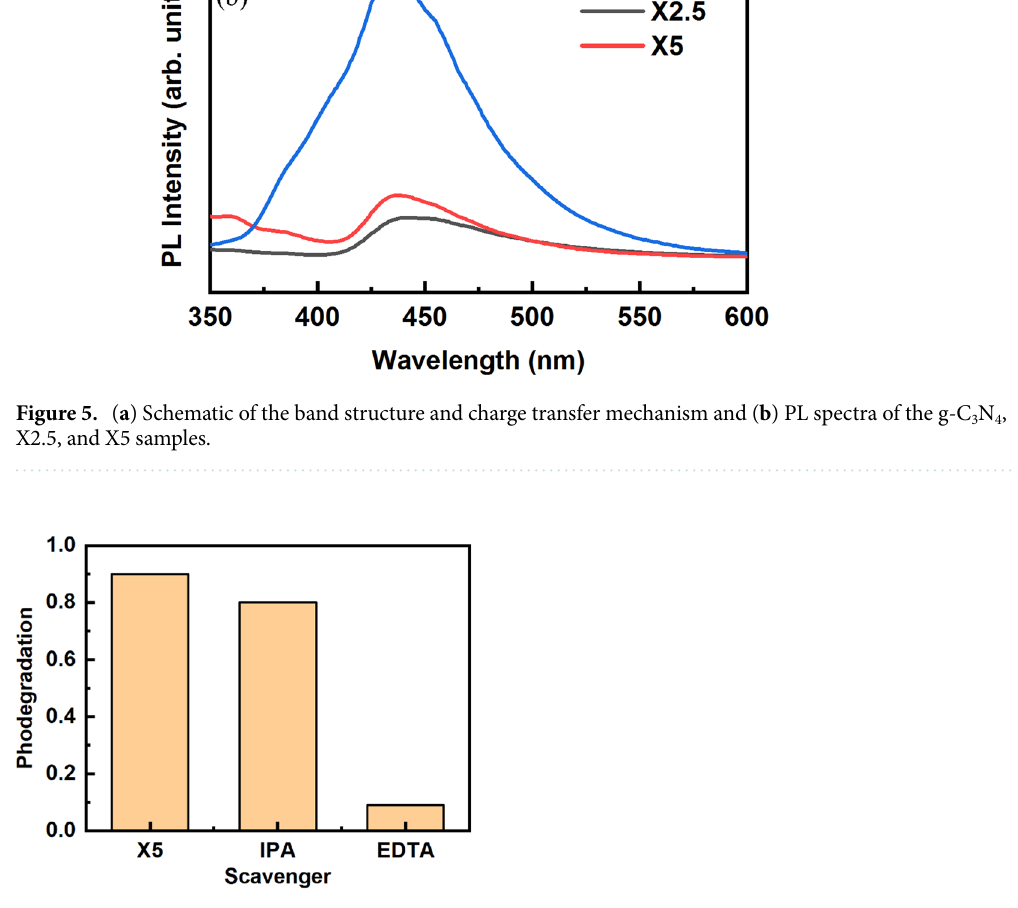
Figure 6. Photodegradation of the MB dye by the X5 composite powders in the presence of a series of